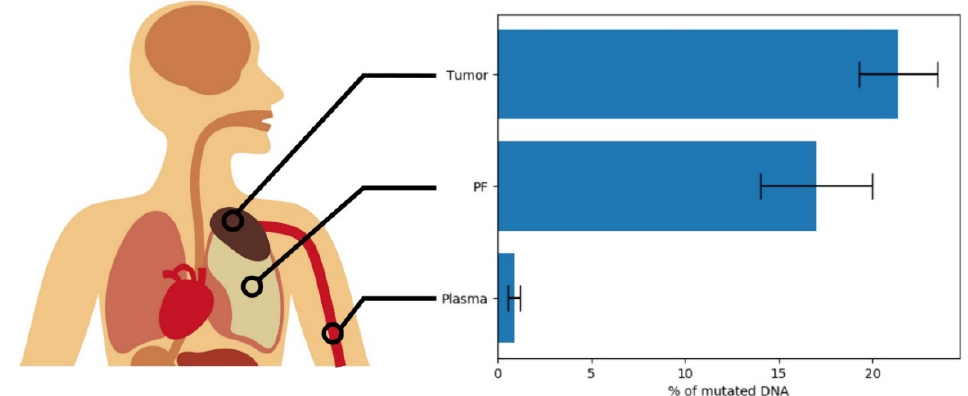
Figure 1. Mean levels of mutated DNA found in the samples from three sources: solid tumor, pleural fluid, and plasma.